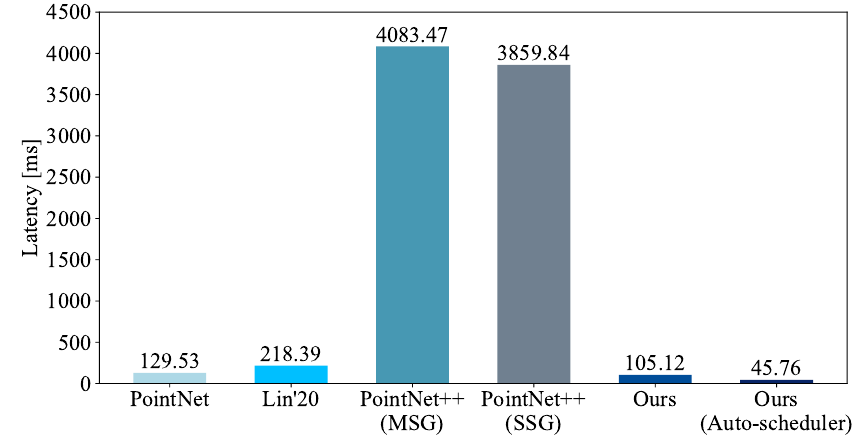
Figure 12. Comparison of the latency on the TX2 CPU.